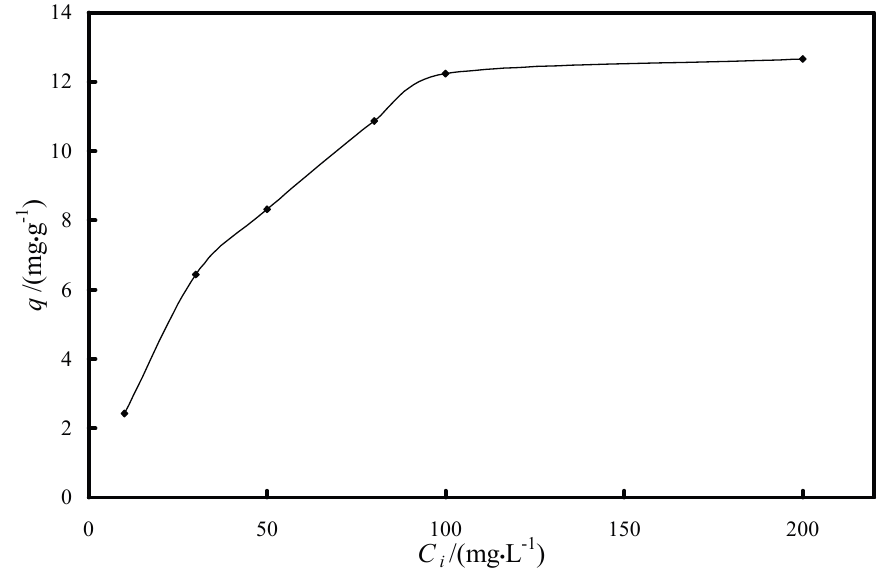
Figure 1. Dependence of the Fe(III) ions uptake versus the initial concentration of Fe(III) pH = 3, t = 24 h, m = 0.1 g, V = 25